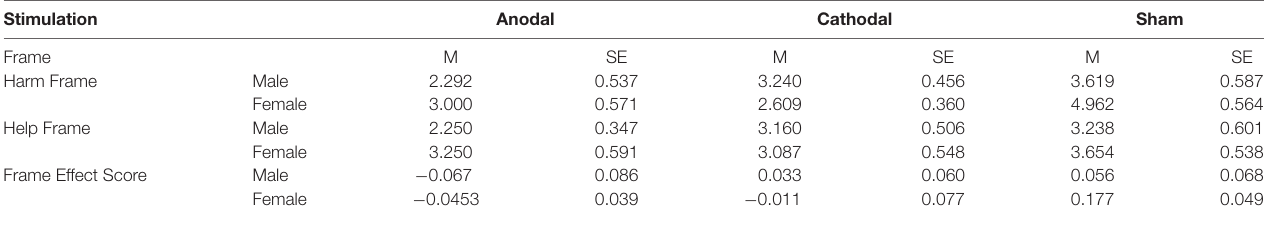
TABLE 3 | Means (M) and standard error (SE) of the data for sex effects of the social framing effects under three conditions. Stimulation Anodal Cathodal